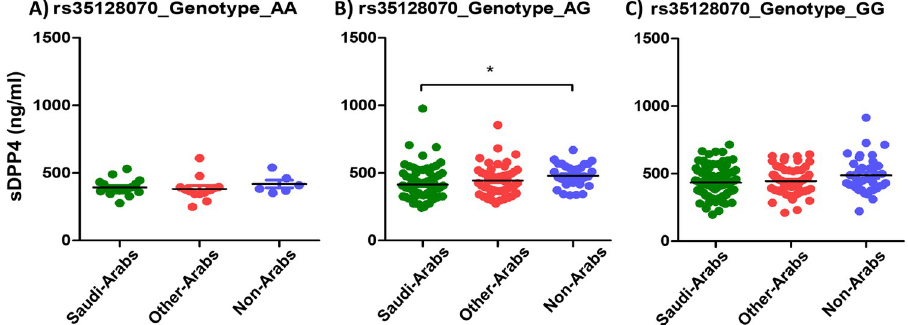
Fig 3. Average sDPP4 levels among different ethnic groups in relation to the rs35128070 genotypes.